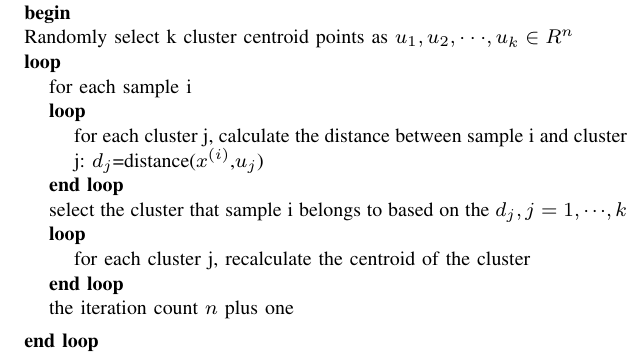
Algorithm 1 Drug Clustering